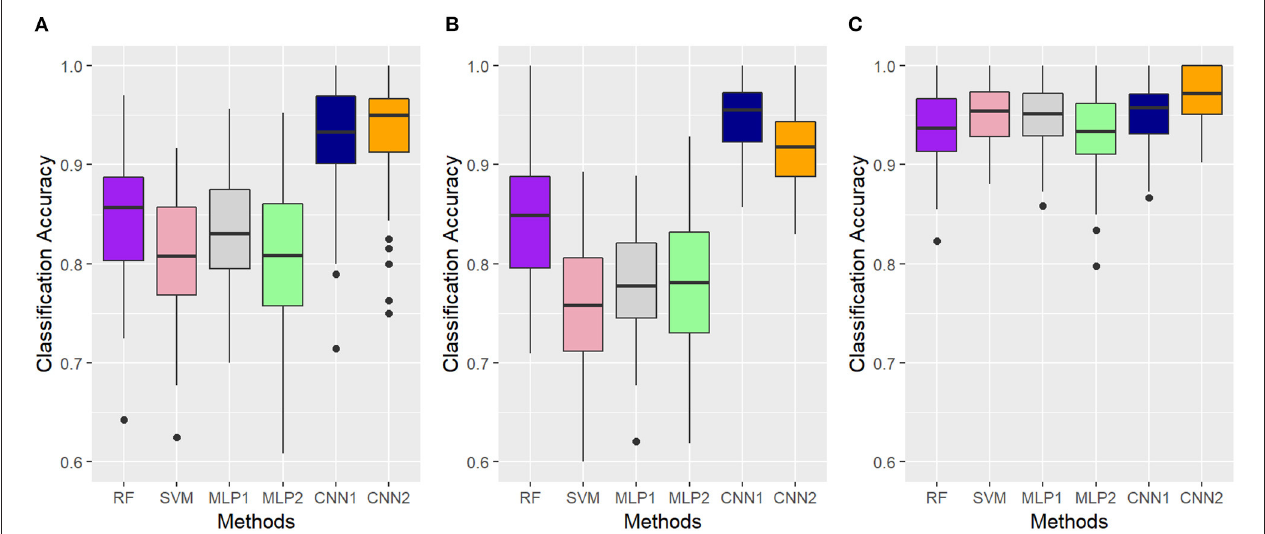
FIGURE 8 | Accuracy values obtained with different algorithms (RF, Random Forest; SVM, Support Vector Machine; MLP, Multilayer Perceptron Neural Networks; CNN, Convolutional Neural Networks) for the classification of gait types ( marcha batida —MB or marcha picada —MP) in Brazilian horses according to the audio-feature dataset used as input information ( A —Mel-frequency Cepstral Coefficients, B —Onset Strength and C —Tempogram). Classification accuracy was assessed using a five-fold cross-validation scheme with 10 random repetitions. MLP1, MLP2, CNN1, and CNN2 refer to the different neural network architectures used for each audio-feature dataset, as fully described in Supplementary Table 1